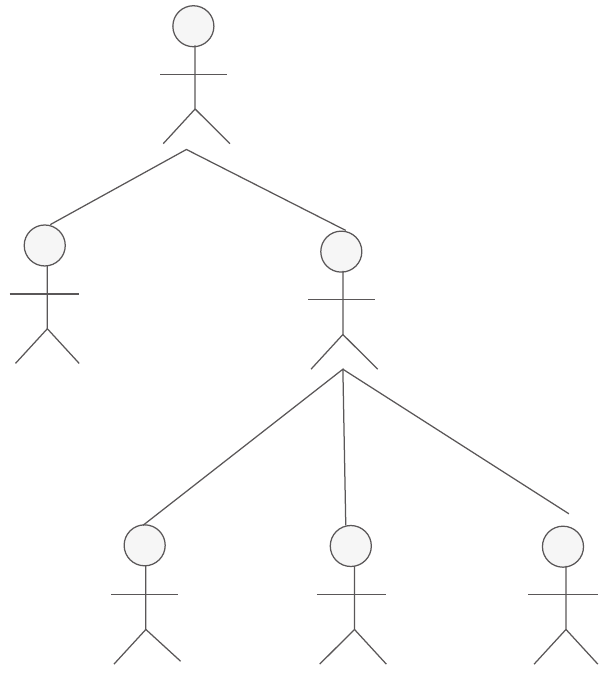
Figure 3: System roles use case